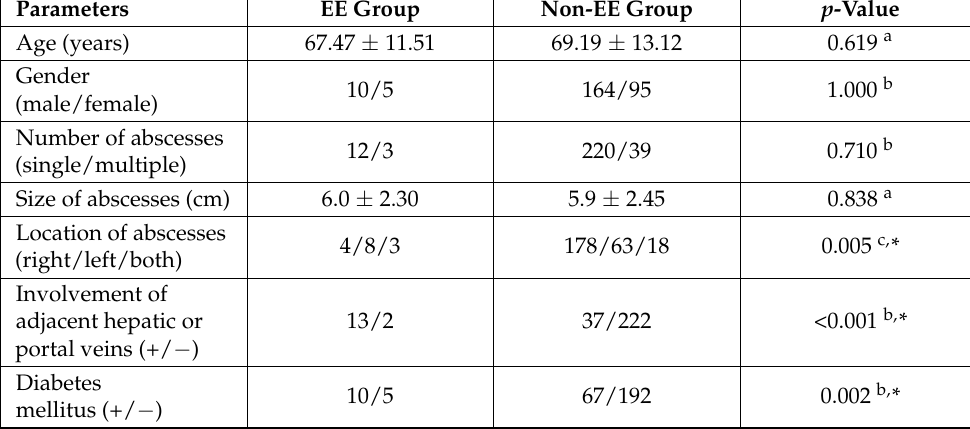
Table 2. Comparison of the demographics and computed tomography findings between the endoge- nous endophthalmitis group and non-endogenous endophthalmitis group in patients with Klebsiella pneumoniae liver